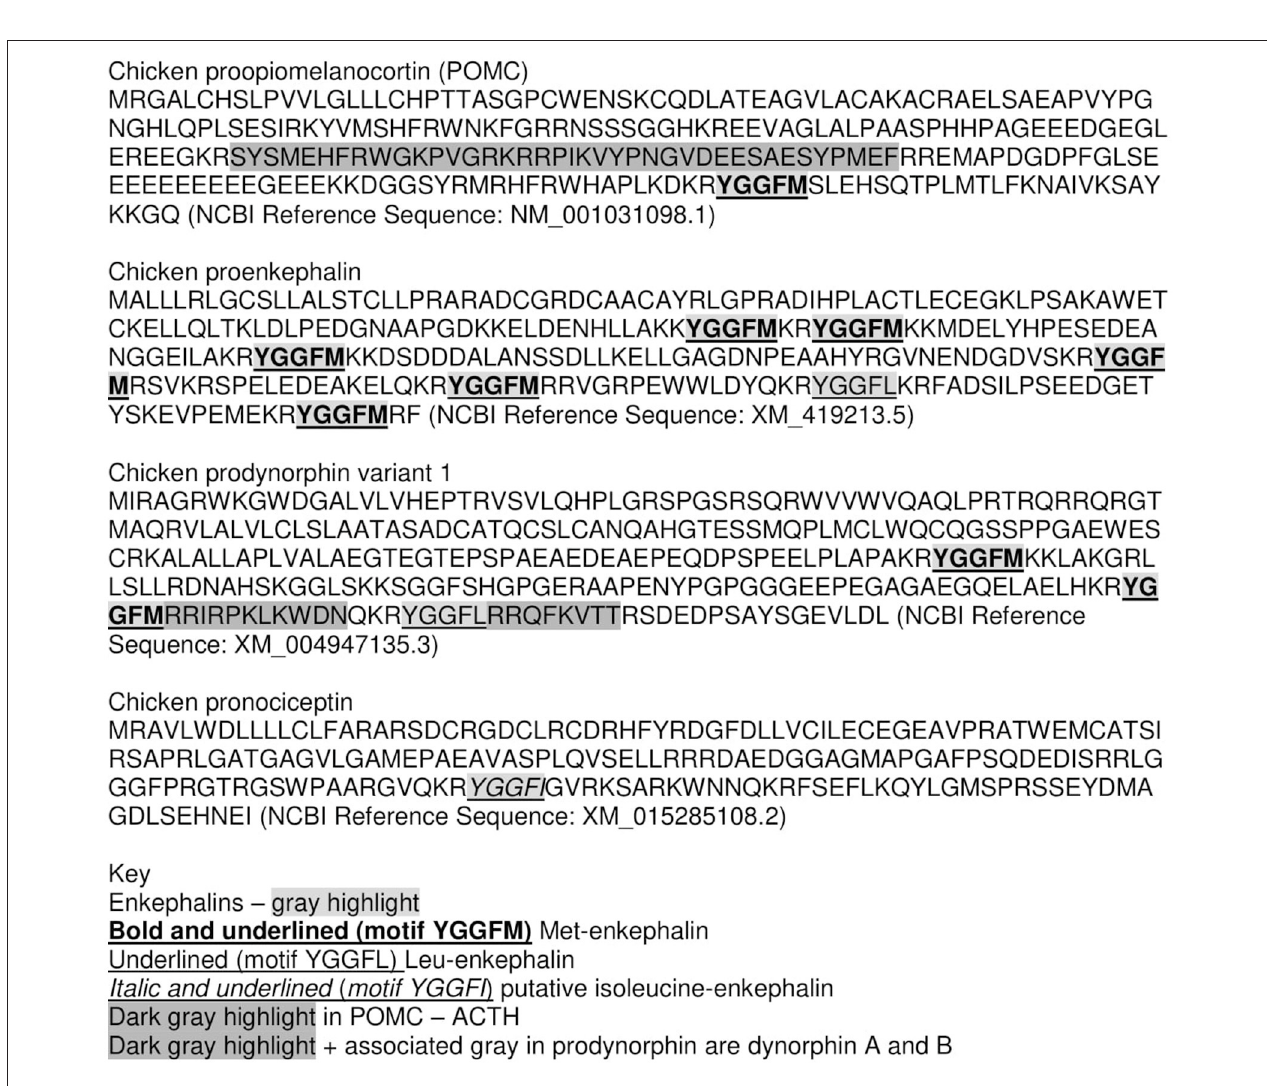
FIGURE 1 | Structures of avian endogenous opioids deduced from